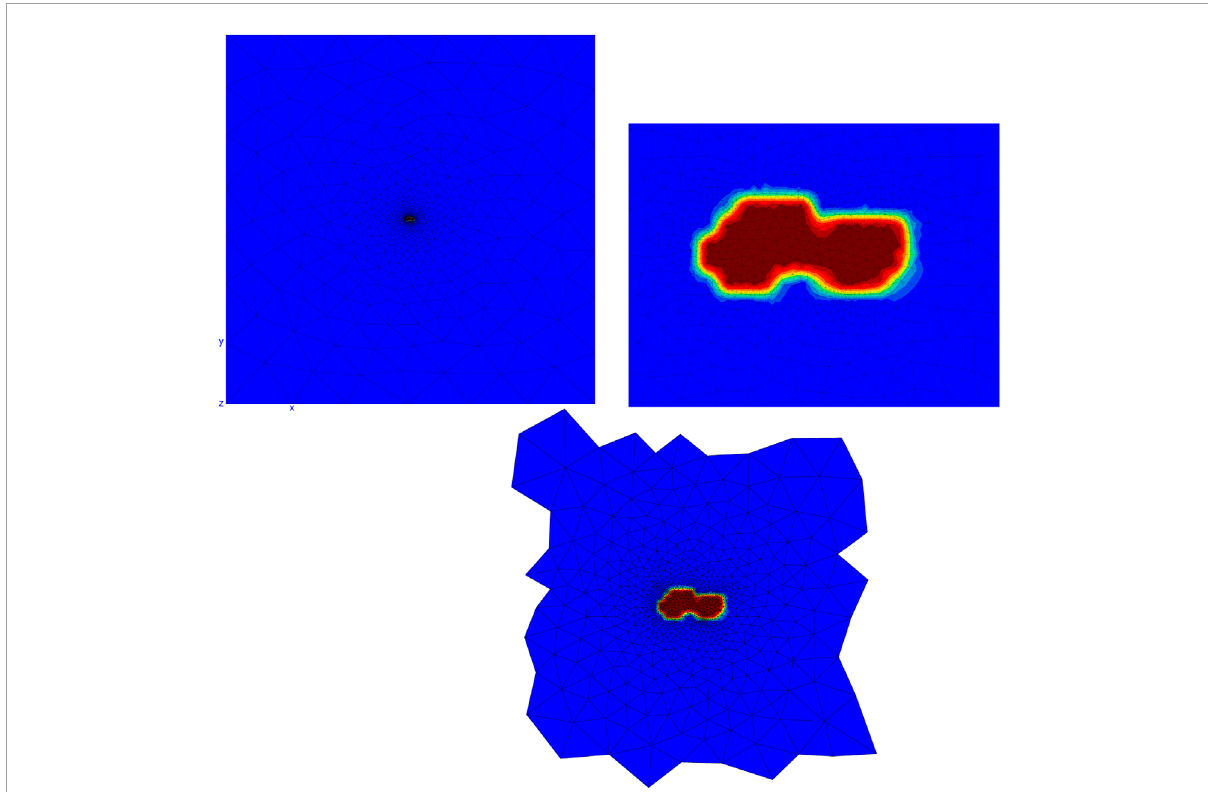
FIGURE 2 The finite element mesh of one digital twin (on the left), a focus on the phase field of the void at the center of this mesh (Right), and the mesh of the reduced domain Ω R